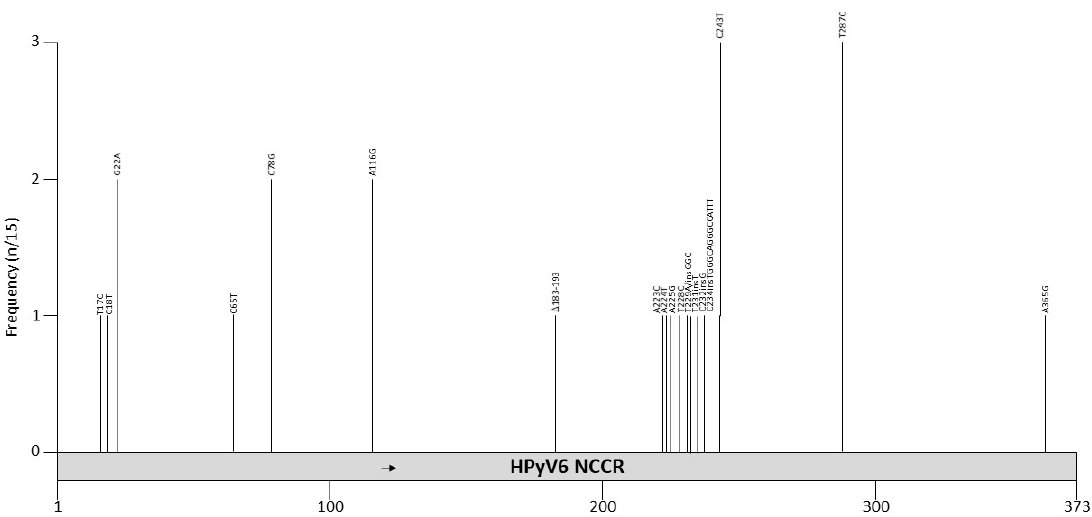
Figure 5. Mutations and their prevalence in variants of HPyV6 noncoding control region (NCCR). The numbering of the NCCR is from early to late with nucleotide 1 being the most proximal to the ATG start codon of the early genes and the most distal nucleotide, just upstream of the start codon of the VP2 gene. The number of times a peculiar mutation is found in the different variants is given as frequency (with n the number of times the mutation was described / total NCCR variant sequences available). Putative Large T antigen (LT) binding motifs 5 ′ -GRGGC-3 ′ ( → ) or 5 ′ -GCCYC-3 ′ ( ← ) are shown. The table summarizes the mutations, their location in the NCCR, and their frequency. For details see Table S1. Putative transcription factor binding sites are shown in Supplementary Table S2. Table 7. Frequency of mutations in the noncoding control region of HPyV6.